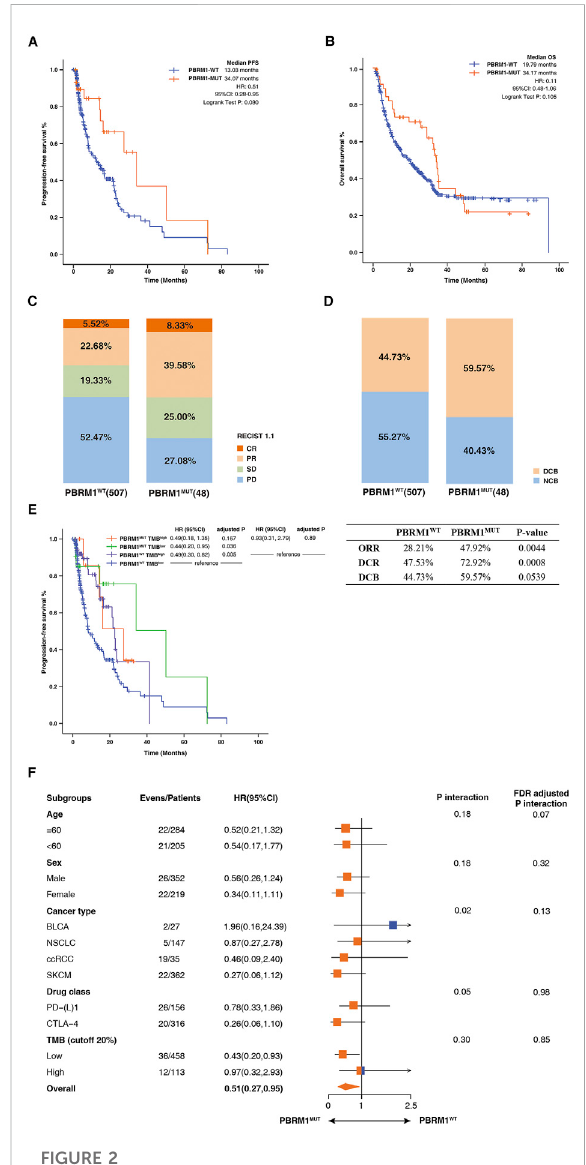
FIGURE 2 Association between PBRM1mutation and ICIs ef fi cacy in the discovery cohort. (A) The Kaplan-Meier survival analysis comparing PFS between PBRM1-MUT and PBRM1-WT patients in thediscoverycohort. (B) TheKaplan-Meiercurvescomparing OS between PBRM1-MUT and PBRM1-WT patients in the discovery cohort. (C) Histogramdepicting proportions ofORRand DCR in PBRM1-MUT and PBRM1-WT patients. (D) Histogram depicting proportions of DCB and NCB in PBRM1-MUT and PBRM1-WT patients. (E) The Kaplan-Meier curves comparing PFS amongPBRM1 MUT TMB high ,PBRM1 MUT TMB low ,PBRM1 WT TMB high ,and PBRM1 WT TMB low groups in the discovery cohort. (F) Subgroup analysis of PFS in the discovery